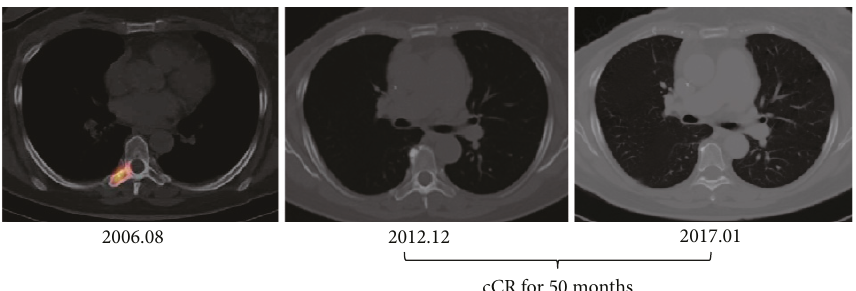
Figure 2: Follow-up SPECT-CT of vertebra Th7 of Case #6 (assigned as cCR Case 1 ) [20]. No recurrence in vertebra Th7 was observed.